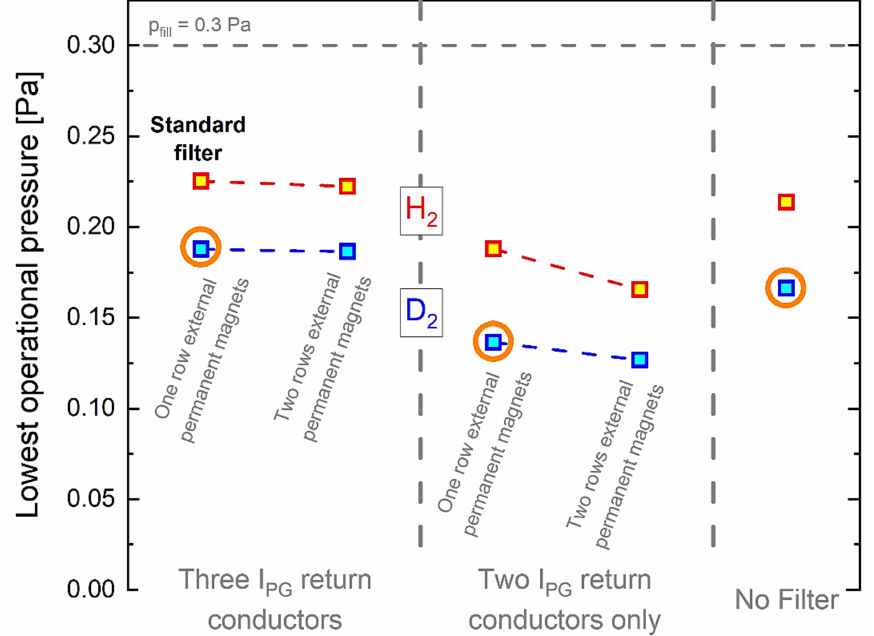
Figure 3. Lowest operational pressure of the ELISE ion source for different topologies of the magnetic filter field. The configurations indicated by the circles are investigated in more detail. The dashed hori- zontal line illustrates the filling pressure foreseen for the ITER neutral beam heating (NBI) ion